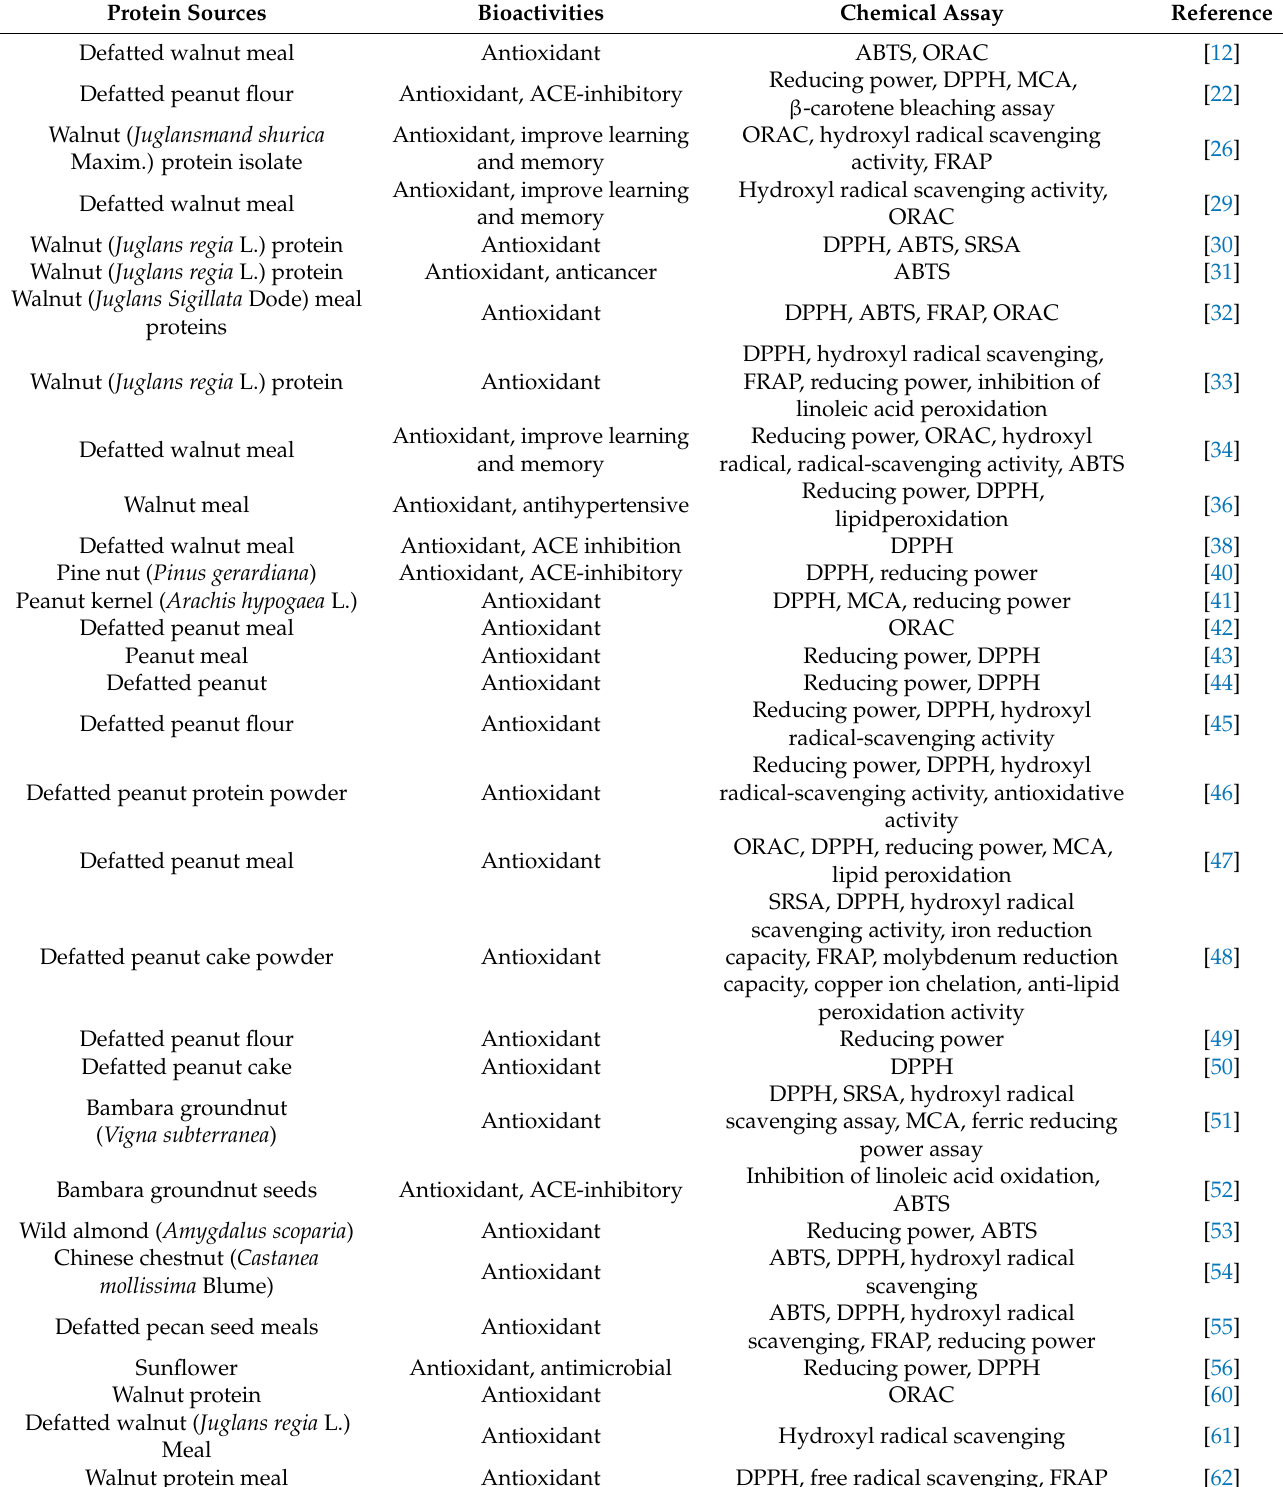
Table 3. Evaluation of antioxidant activity of nut-derived peptides by chemical